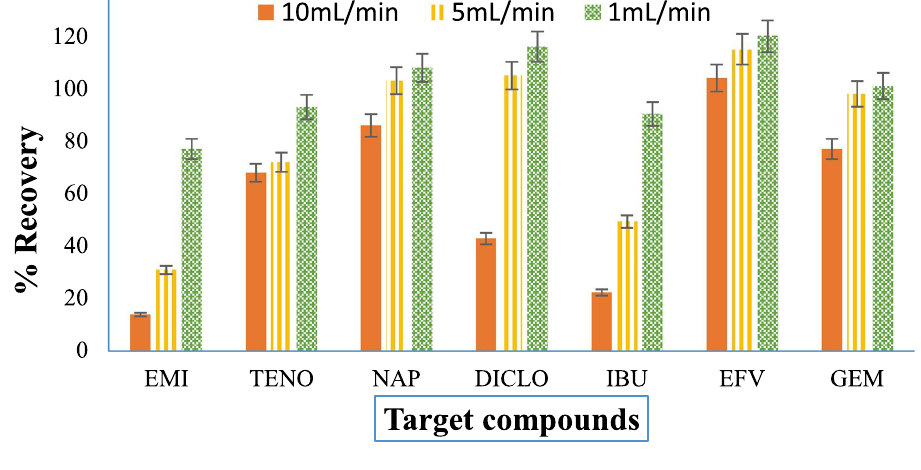
Fig. 4 The effects of elution flowrate on the percentage